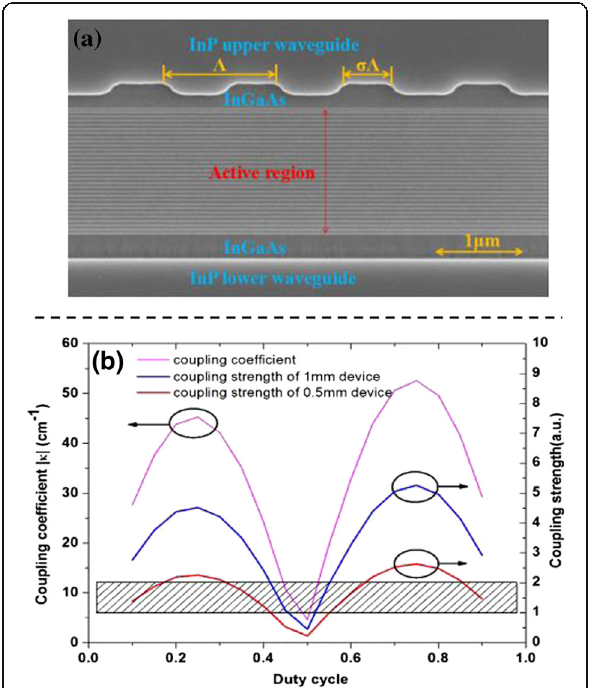
Fig. 1 a The SEM image of the buried grating and b the simulated coupling coefficient and coupling strength of the buried second-order grating with